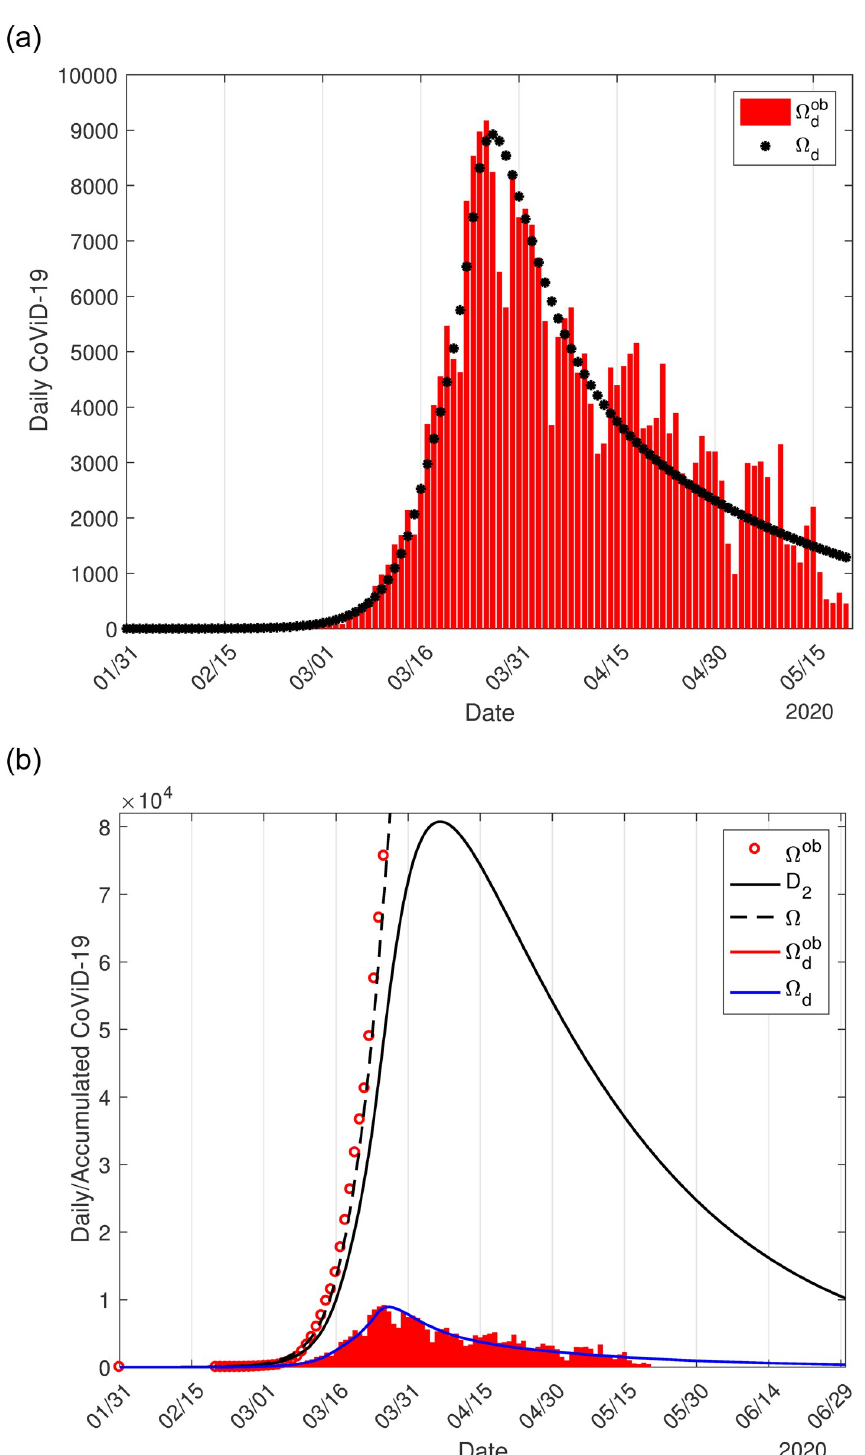
Fig 7. The calculated curve O d and the observed daily cases in Spain (a), and the initial part of the estimated curve O with observed data O ob , the extended O and daily observed cases O ob , and severe covid-19 cases D 2 (b). All curves are d d the sum of the cases in circulating and locked-down populations.